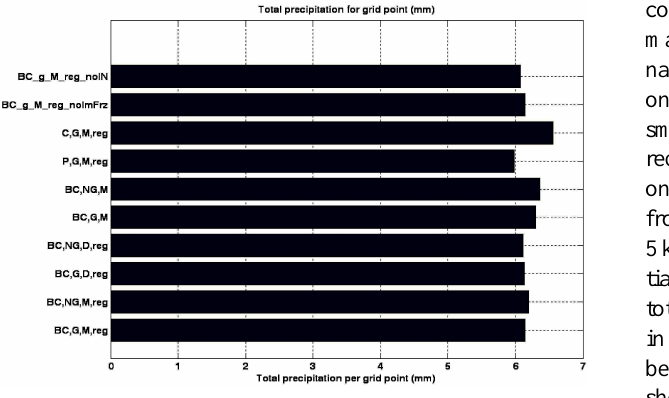
Fig. 5. Total precipitation per grid box (in mm) for the entire domain and simulation